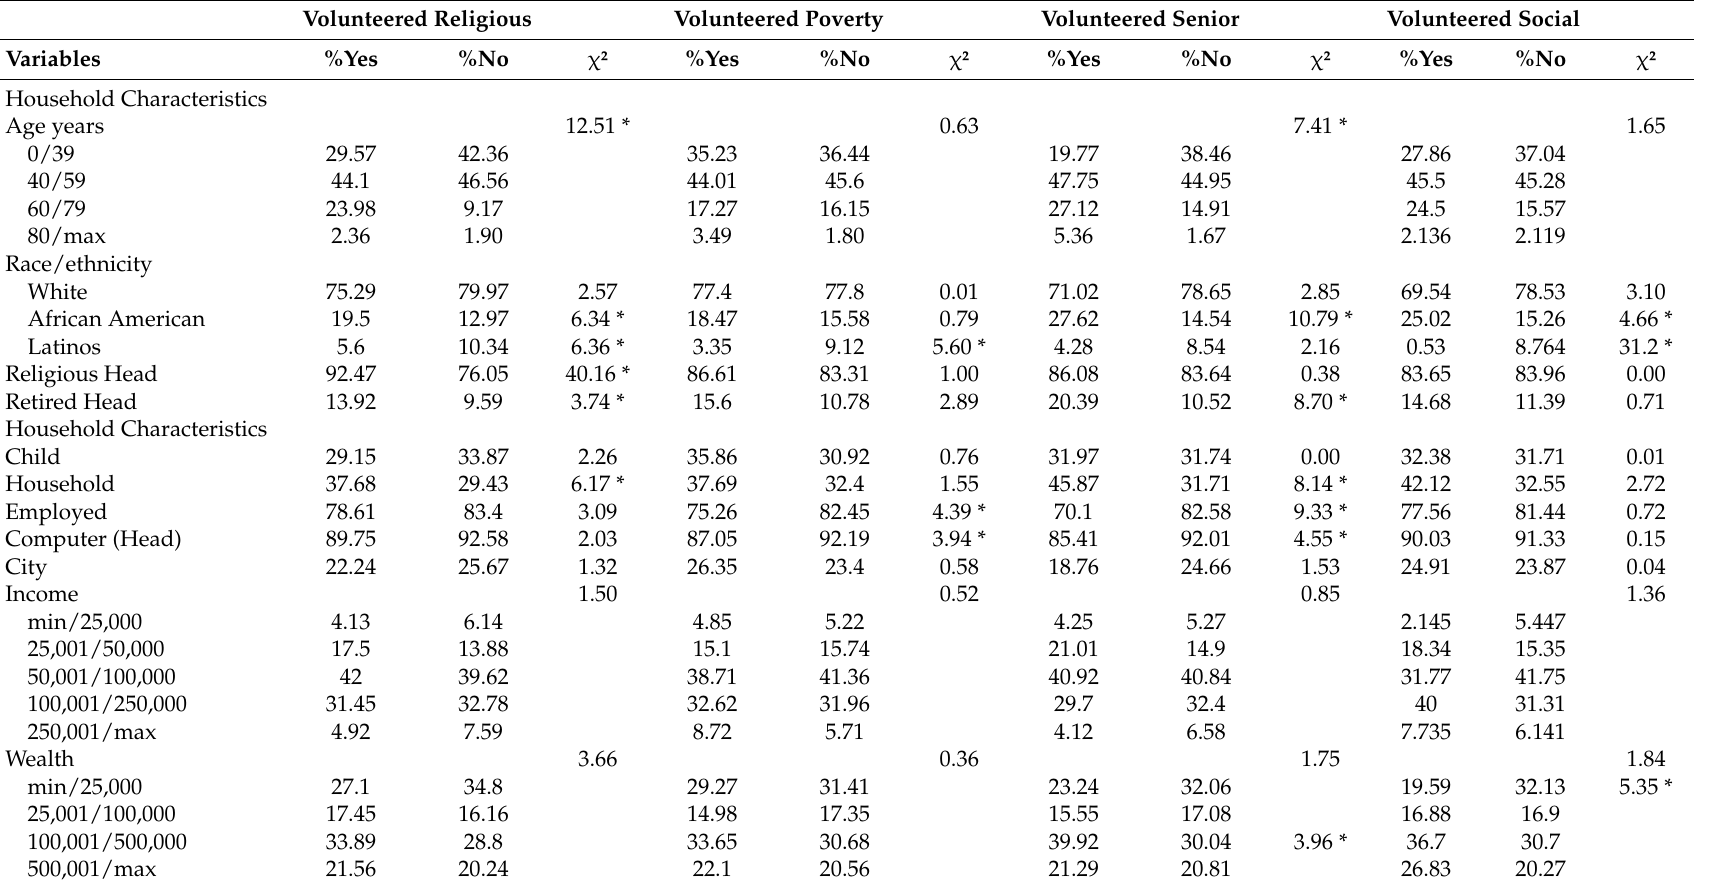
Table 6. Bivariate analysis of independent variables association with wife volunteering (weighted). Volunteered